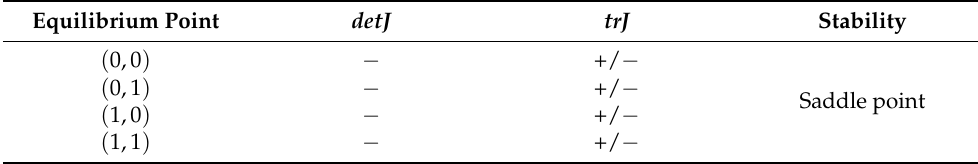
Table 4. Stability analysis results for fixed equilibrium